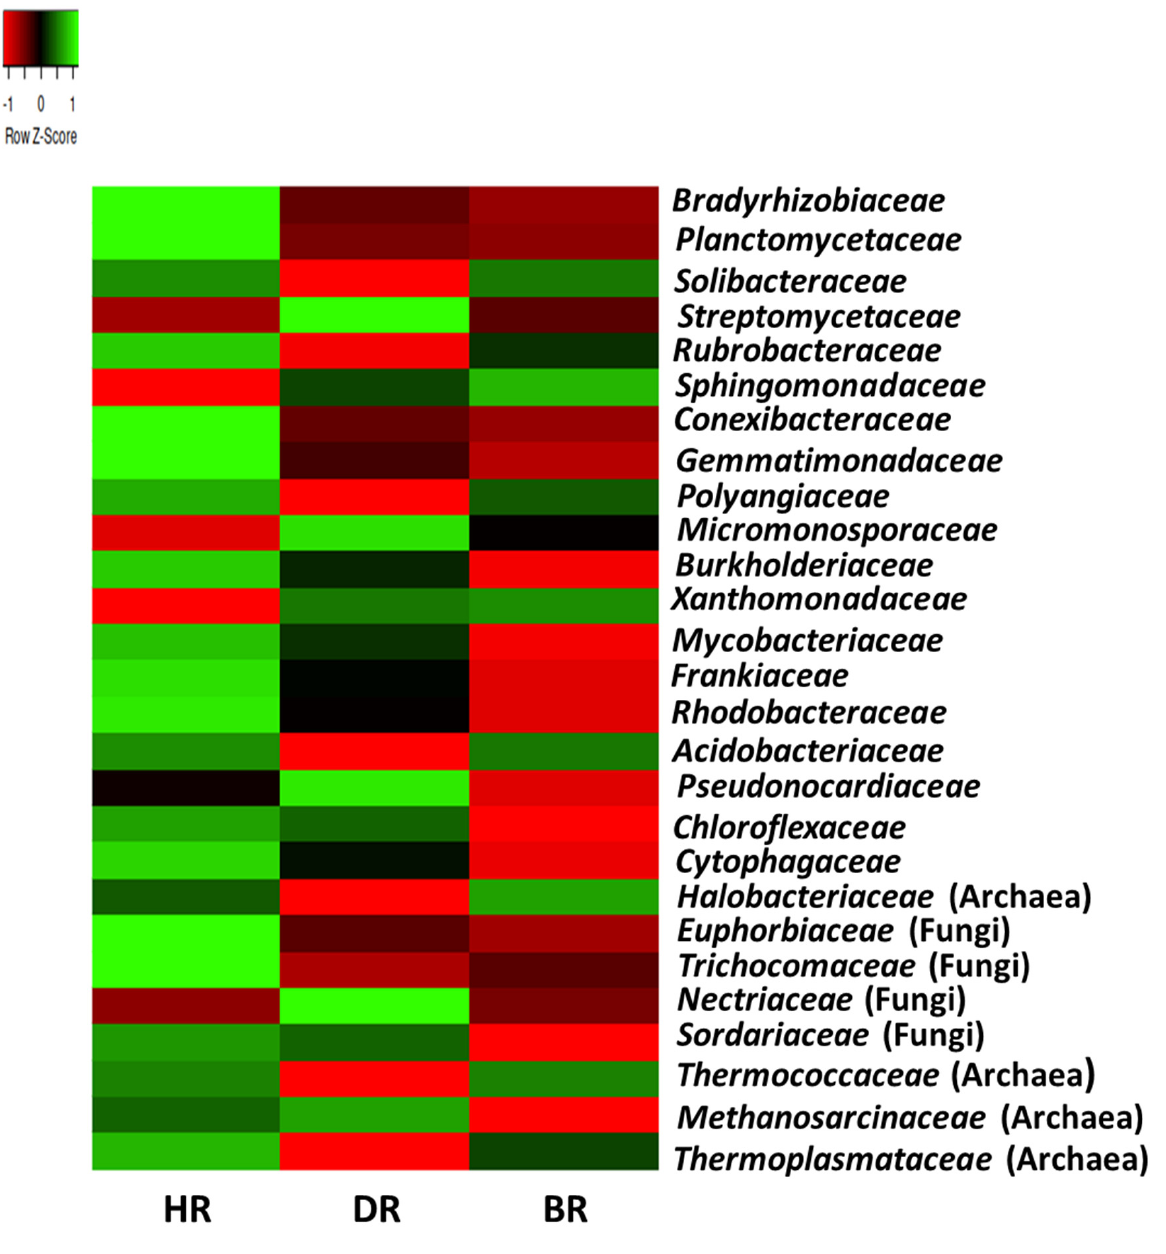
Figure 5. The family heatmap of soil microorganisms affiliated with the tomato plants. Each plot with unique color functioned as a saturation gradient employing the mean value with a z-score. HR = rhizosphere soil of healthy tomato plant; DR = rhizosphere soil of diseased tomato plant; and BR = bulk soil obtained from the soil without tomato plantation.